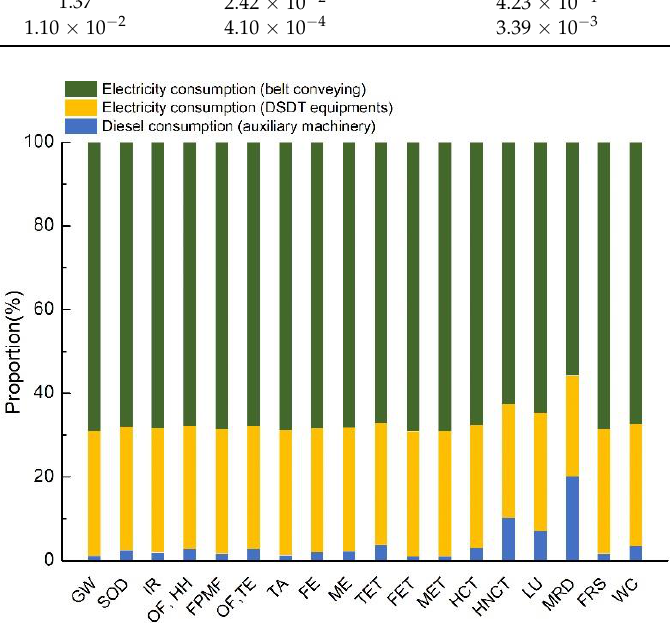
Figure 6. Normalized LCA results for Scenario 2.